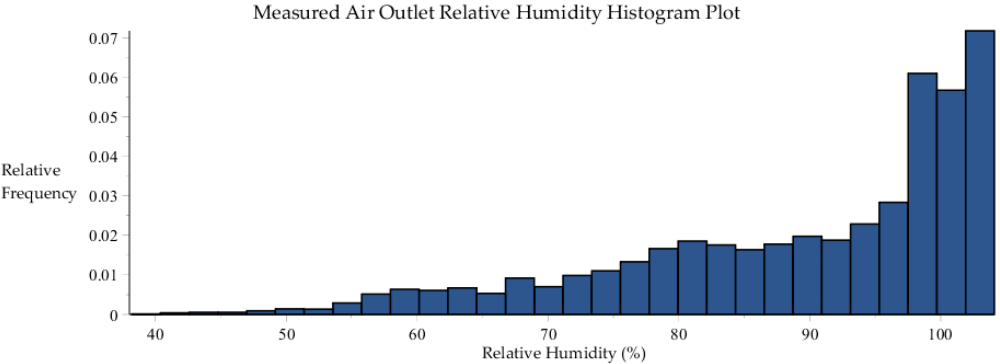
Figure A2. Histogram plot of the measured air outlet relative humidity, within the 6717 data sets collected by SRNL from F-Area cooling towers.